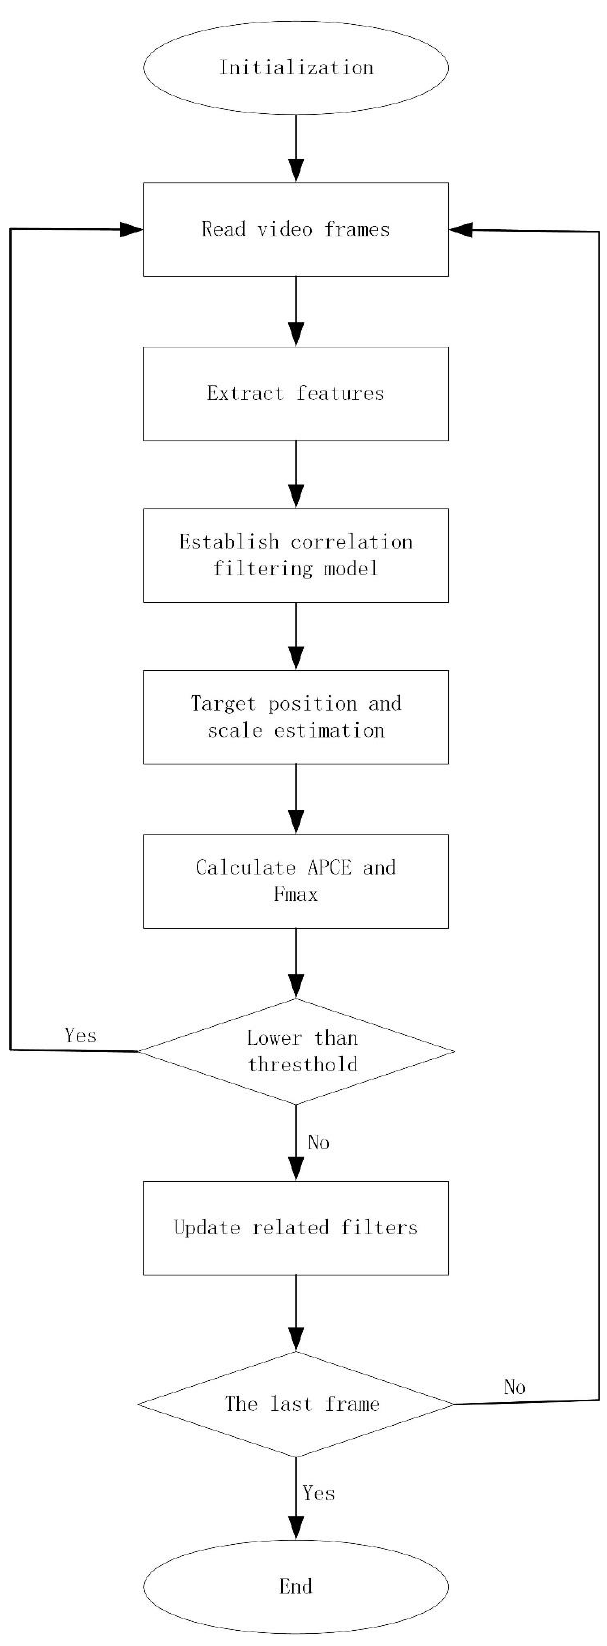
Figure 2. Structure of the FSRCF tracker in this paper.